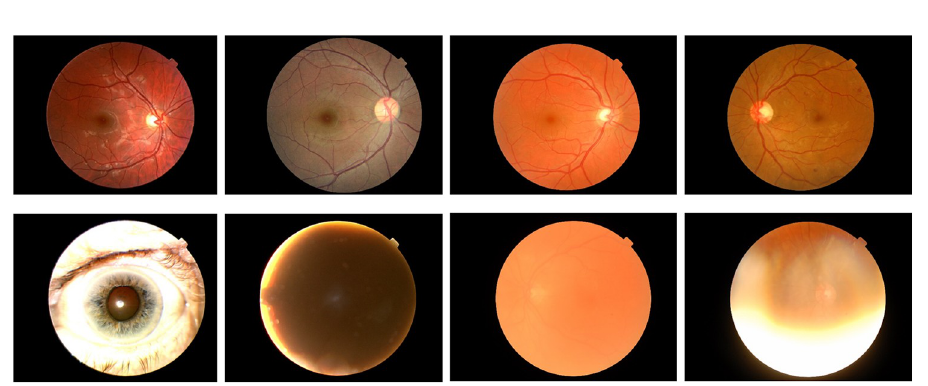
Fig 2. Samples of ‘adequate’ and ‘in-adequate’ images as decided by a senior retinal specialist. Fundus images deemed adequate are shown in the upper row. Fundus images deemed inadequate are shown in the bottom row.